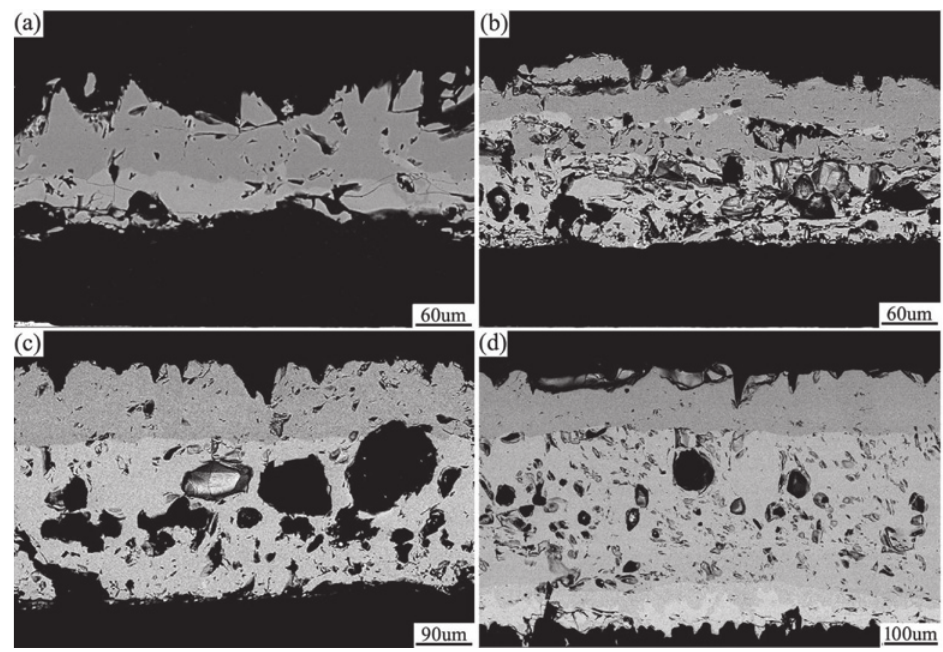
Fig. 5: Cross section morphology of the external scale: (a) 1273 K, (b) 1373 K, (c) 1423 K, (d) 1473